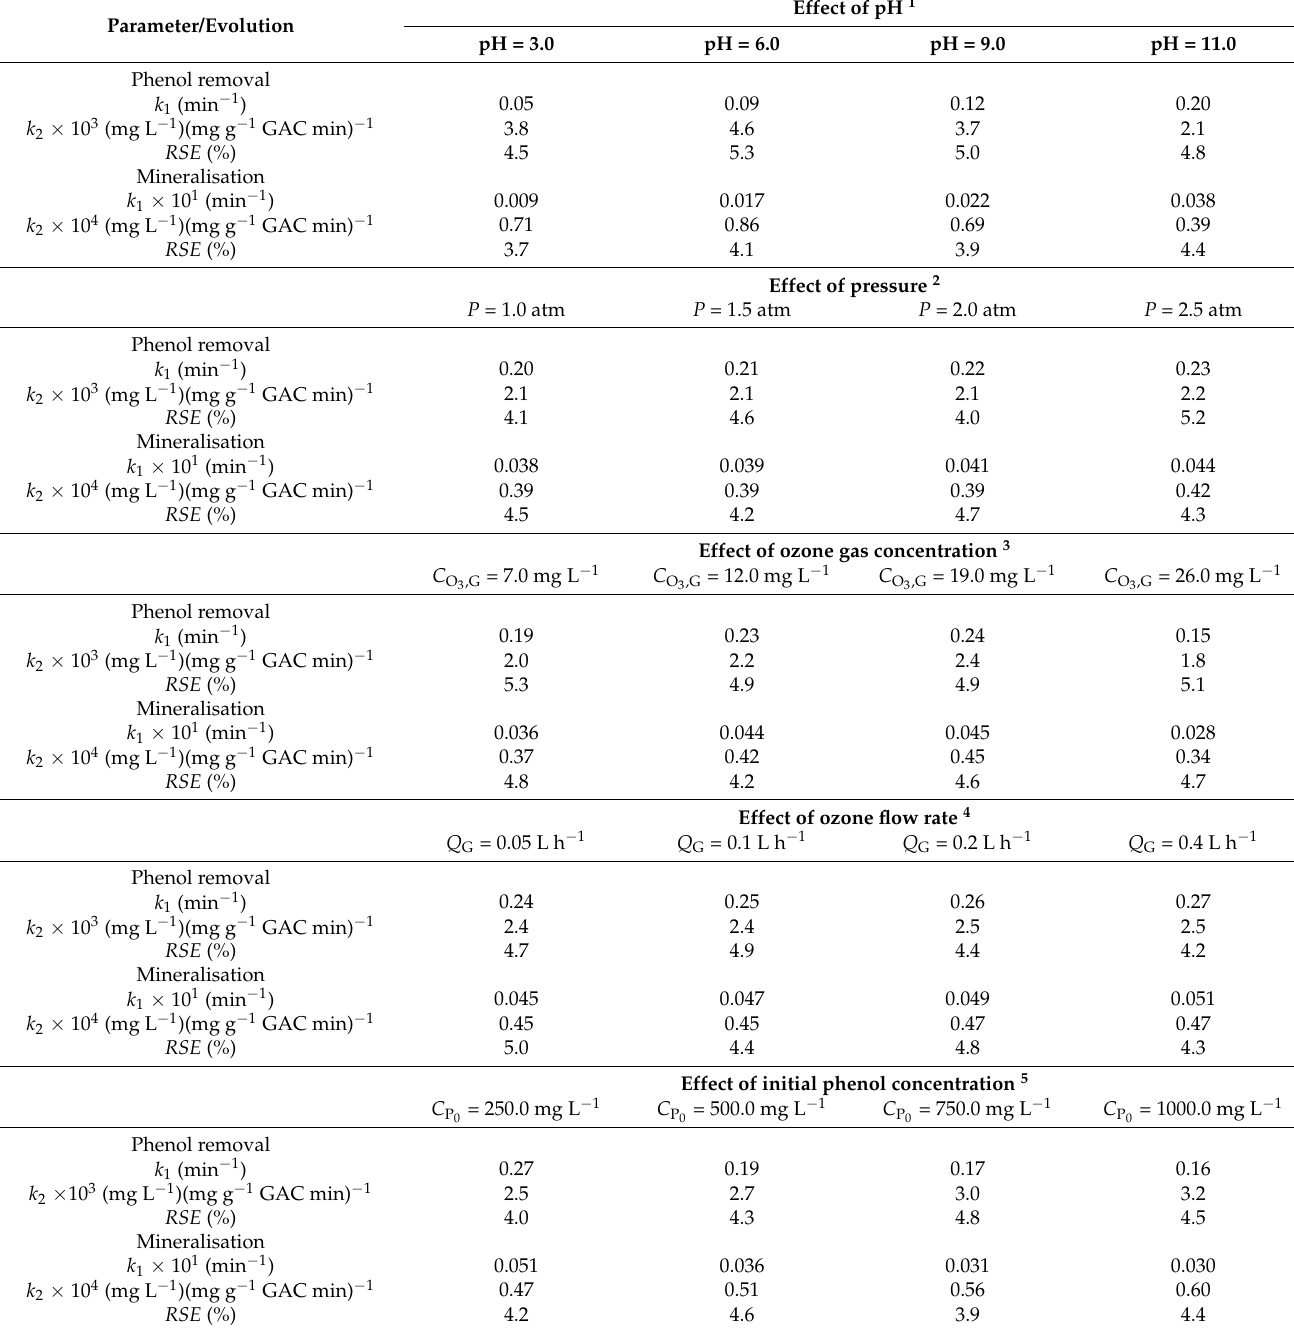
Table 2. Summary of the adsorption and oxidation kinetic constants of the Ad/Ox kinetic model related to the removal and mineralisation of phenol during catalytic ozonation with